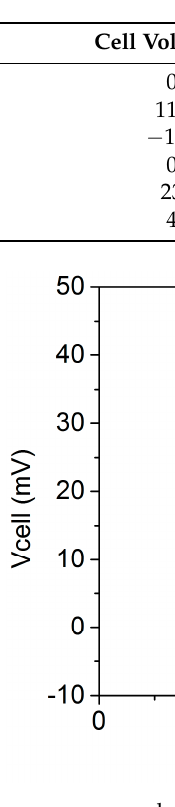
Figure 8. Sensor response when 0.16 ppm of phenantrene is added as a function of analyte concentration, C 2 H 4 in red, and CO in black. The effect of background concentration (200 ppm) of the second analyte is depicted. Each point is the average of the respective 20 min change in response. Table 3. Sensor response to several conditions: Ar+6%O 2 base gas, toluene, methylnaphtalene, phenantrene, C 2 H 4 , and carbon monoxide. Concentration, cell voltage, and sensor sensitivity as mV/ppm are provided.